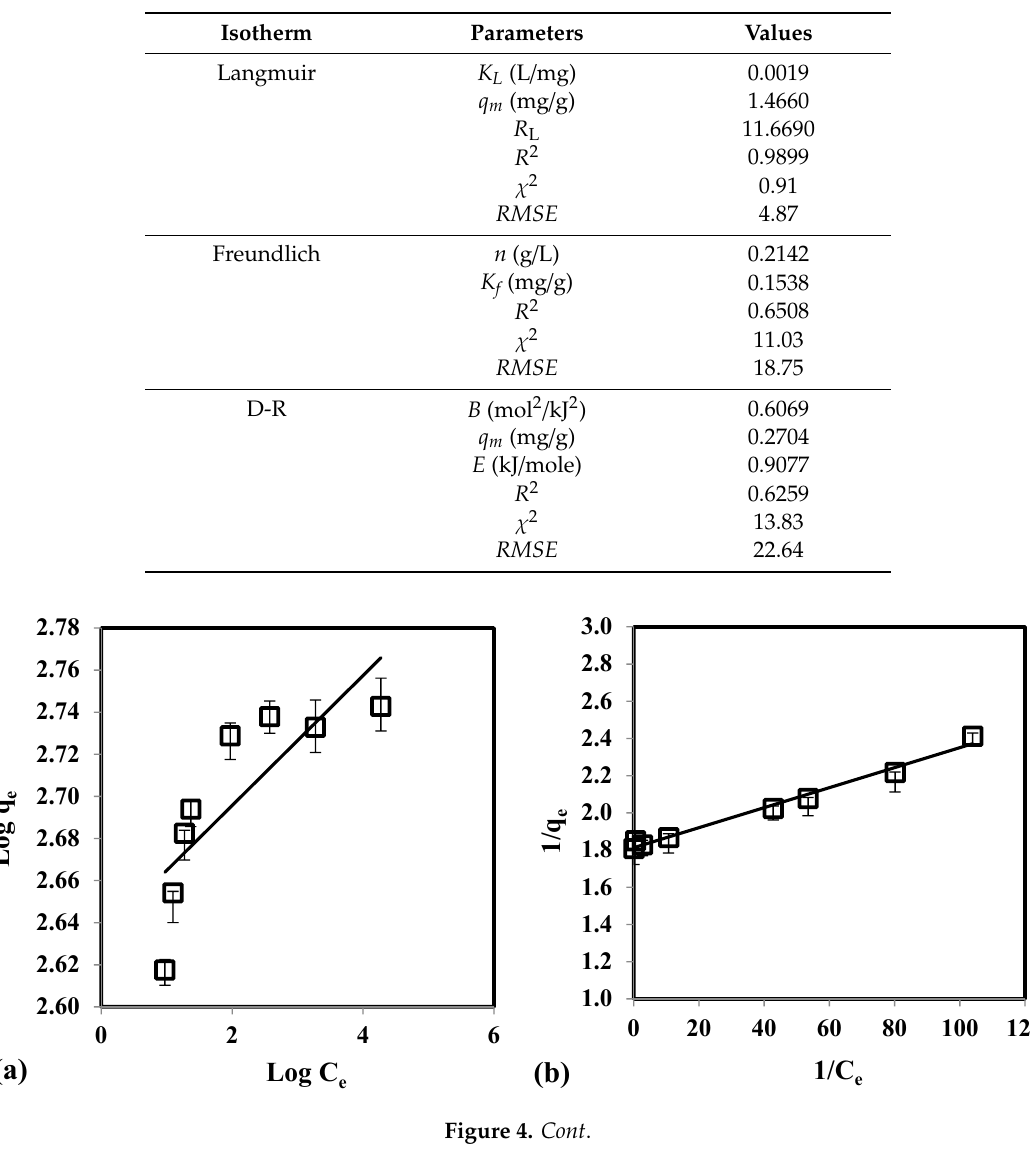
Table 3. List of isotherm parameters for the removal of As(V) using CCB.